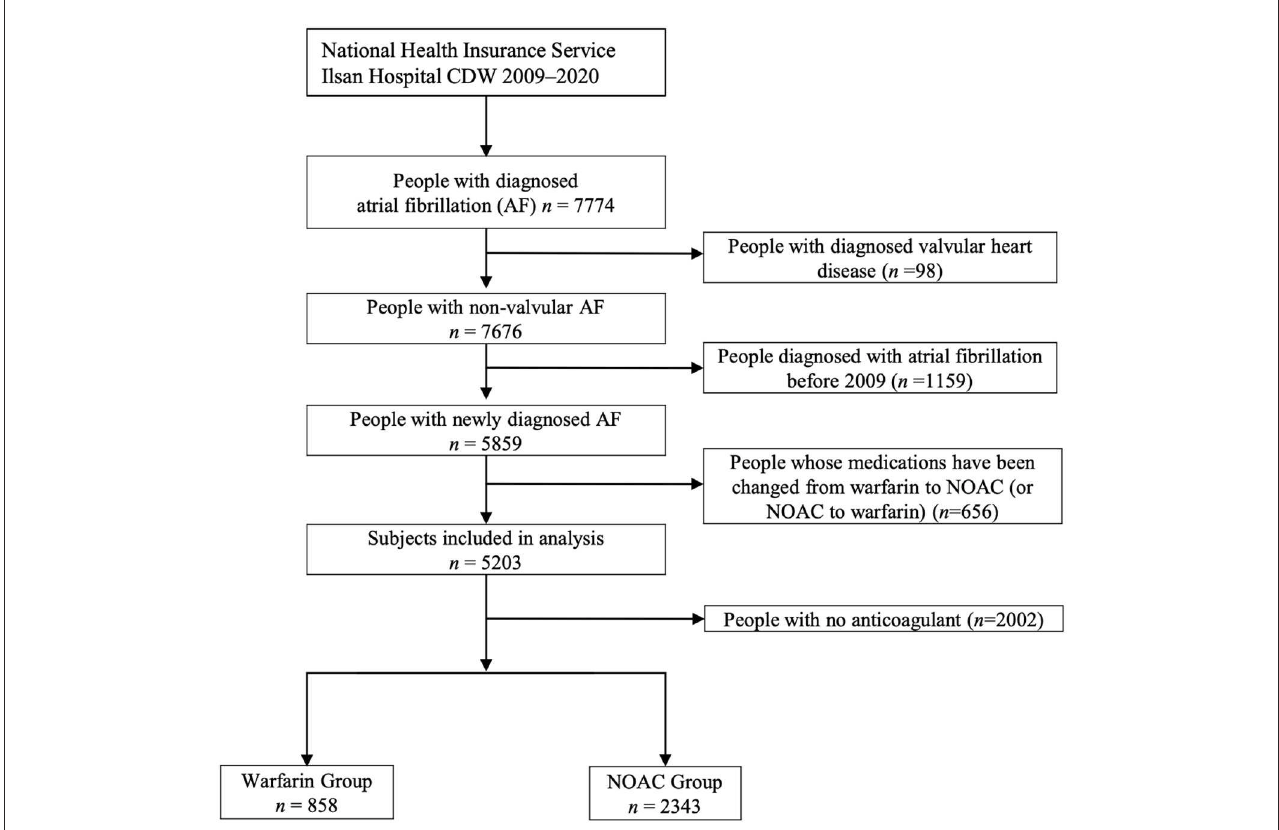
FIGURE1 The process of extracting patients with atrial fibrillation from the clinical data warehouse (CDW), combining them with claim data, and selecting study subjects (CDW + C